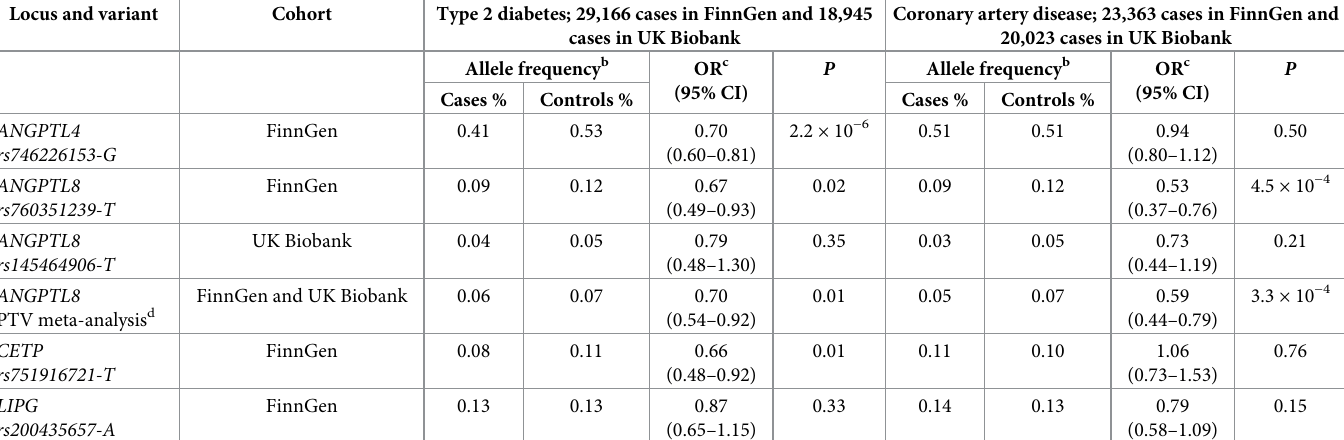
Table 3. Association between protein-truncating variants and T2D and CAD risk in the FinnGen Study and UK Biobank. a